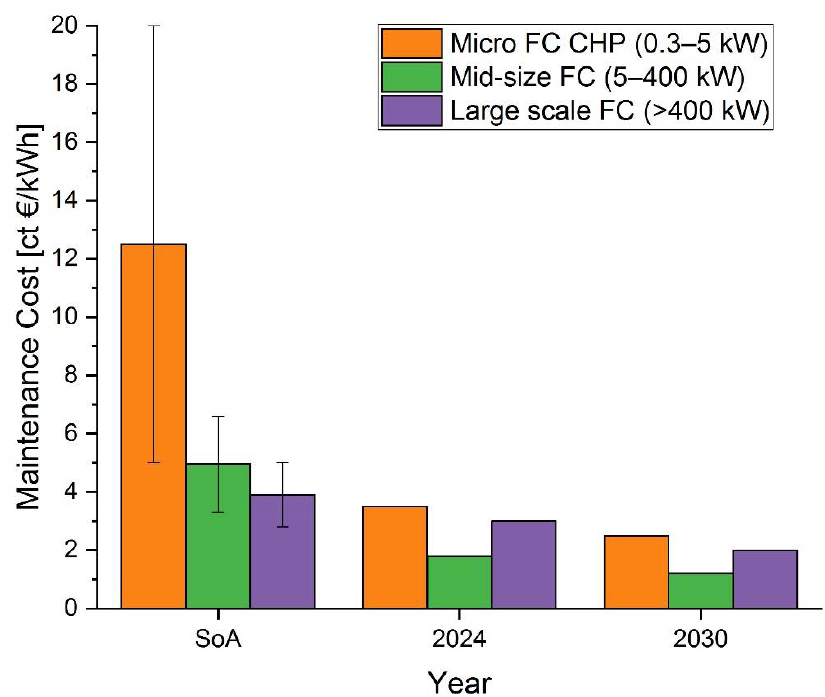
Figure 8. Fuel cell capital expenditure forecast.